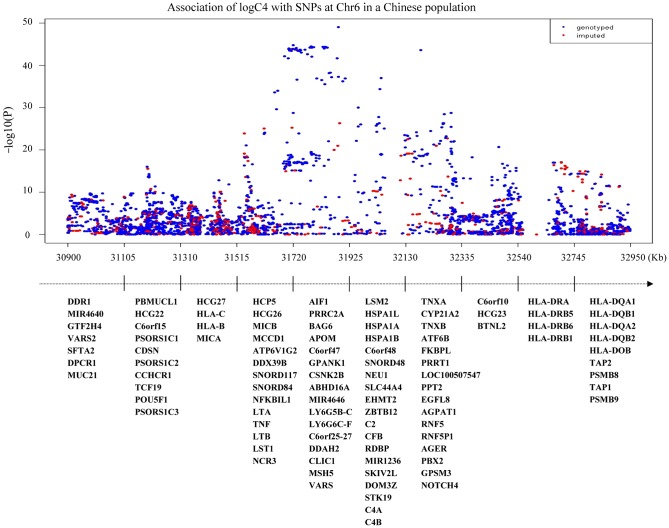
Association of serum C4 levels with SNPs at 6p21.3.X-axis shows base positions from 30,900 Kb to 32,950 Kb. Y-axis shows –log10
P-values from linear regression adjusted for age and logBMI. C4 level are log-transformed and fit for a normal distribution. The horizontal solid line indicates the preset threshold of P = 5×10−8. The bottom panels describe all genes in the region.